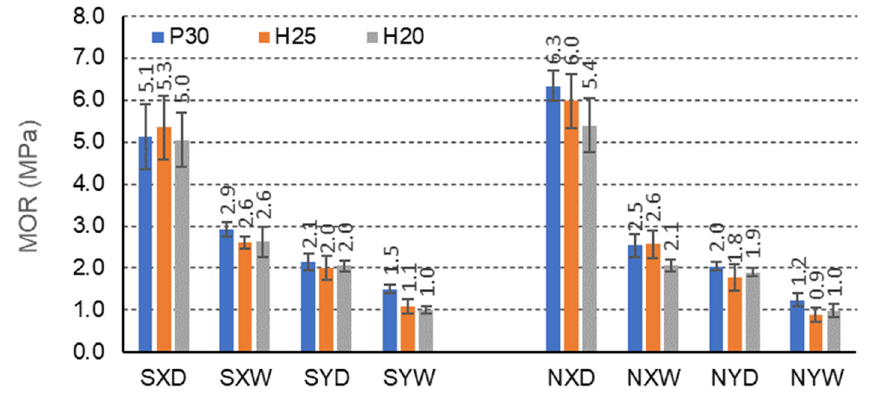
Figure 7. Illustration of the MOR relationship of honeycomb panels with an E-cell core. Whiskers represent standard deviations.